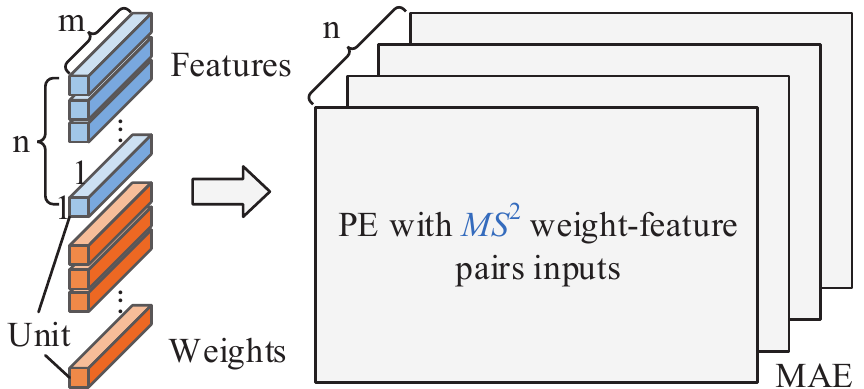
Figure 4. The schematic of minimum cache and access